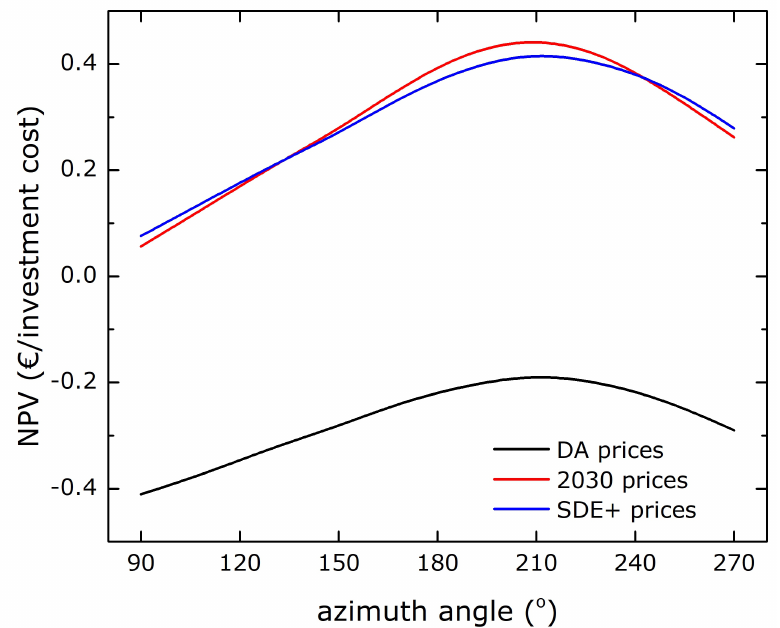
Figure 3. NPV determined for each azimuth angle for DA prices, SDE+ subsidy scheme and 2030